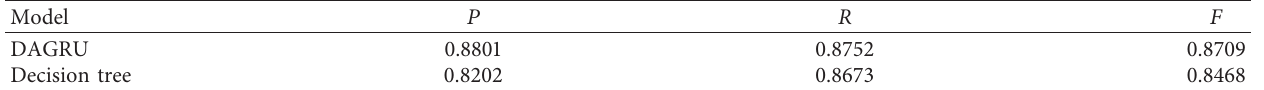
Table 2: Results of whether or not players perform game